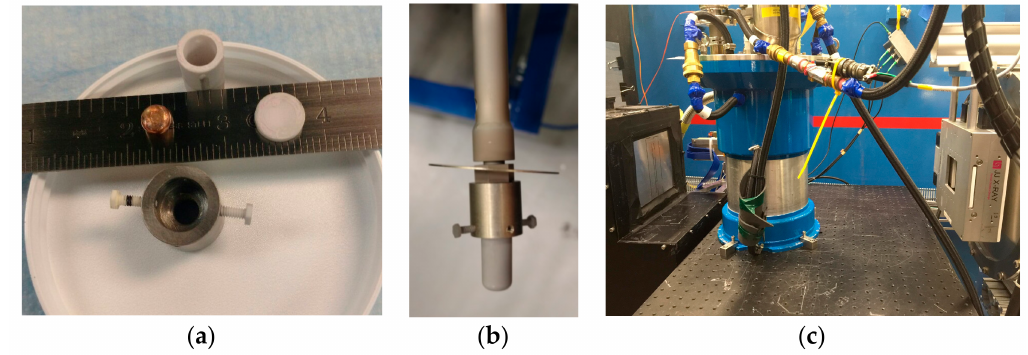
Figure 1. Images of the experimental setup at the CG-1D beamline at the High Flux Isotope Reactor (HFIR) at Oak Ridge National Laboratory. ( a ) Sample of CoCrCu, Al 2 O 3 crucible, lid, and Nb mounting adaptor placed near a ruler for scale. ( b ) The crucible mounted to the sample stick. ( c ) The high-vacuum Institut Laue-Langevin (ILL) furnace placed between the detector and incident neutron beam